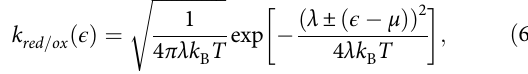
Fig. 3 Temperature-dependent charge-transport in device A . a IV traces of device A at various temperatures (circles) and the global fi t (solid lines) where all parameters except the molecule-electrode couplings are shared. b Zero-bias conductance normalised by ( (cid:1) Γ ¼ Γ of temperature. Black circles: experimental values with error bars (95% con fi dence interval) obtained by propagating a random 0.2 pA error on current measurements with the uncertainty on Γ S and Γ D obtained from the fi ts to the quantum model shown in a . Orange line: Marcus model using λ = 27.6 meV. Green line: Quantum model using one mode and a broad background ( ћ ω = 4.1 meV, S = 0.4, λ o = 26 meV, ω c = 8.3